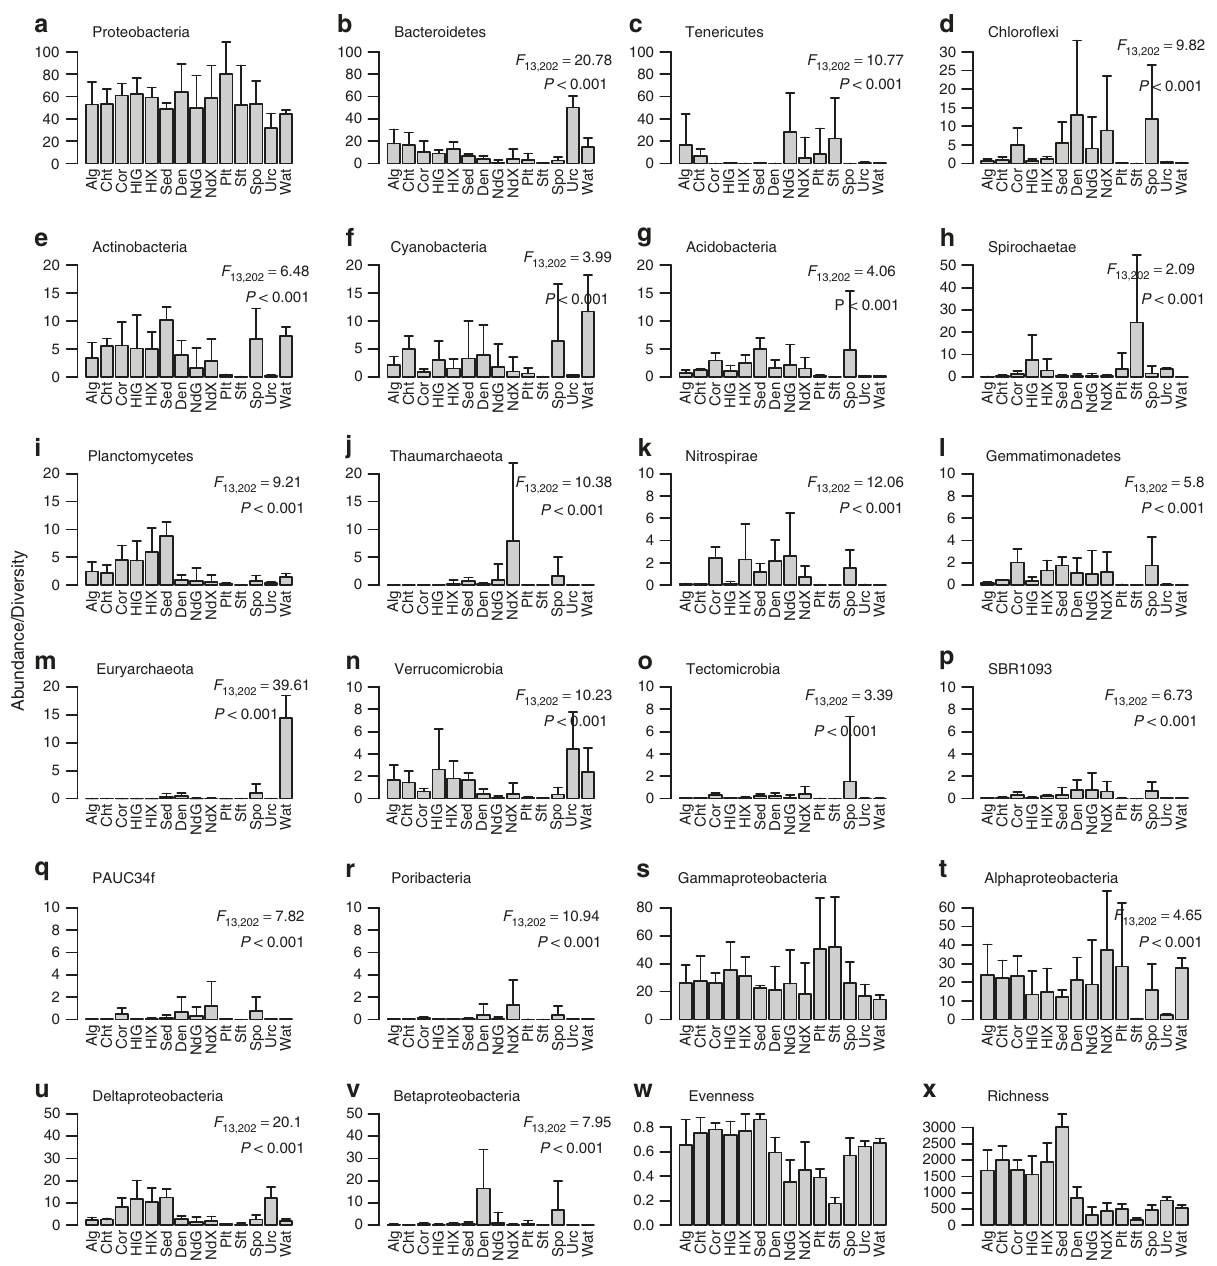
Fig. 2 Mean relative abundance of the most abundant phyla, proteobacterial classes, OTU richness and evenness. Error bars represent a single standard deviation. a Proteobacteria, b Bacteroidetes, c Tenericutes, d Chloro fl exi, e Actinobacteria, f Cyanobacteria, g Acidobacteria, h Spirochaetae, i Planctomycetes, j Thaumarchaeota, k Nitrospirae, l Gemmatimonadetes, m Euryarchaeota, n Verrucomicrobia, o Tectomicrobia, p SBR1093, q PAUC34f, r Poribacteria, s Gammaproteobacteria, t Alphaproteobacteria, u Deltaproteobacteria, v Betaproteobacteria and diversity components, w Evenness and x Richness in the following biotopes: algae (Alg), chitons (Cht), stony corals (Cor), sea cucumber gut (HlG), sea cucumber mantle (HlX), sediment (Sed), sponge denizens (Den), nudibranch gut (NdG), nudibranch mantle (NdX), fl atworms (Plt), soft corals (Sft), sponges (Spo), sea urchins (Urc) and seawater (Wat). When signi fi cant ( P < 0.0023; Bonferroni corrected α value), results of the GLM analyses are presented in the top right of the sub fi gures. Source data are provided as a Source Data fi